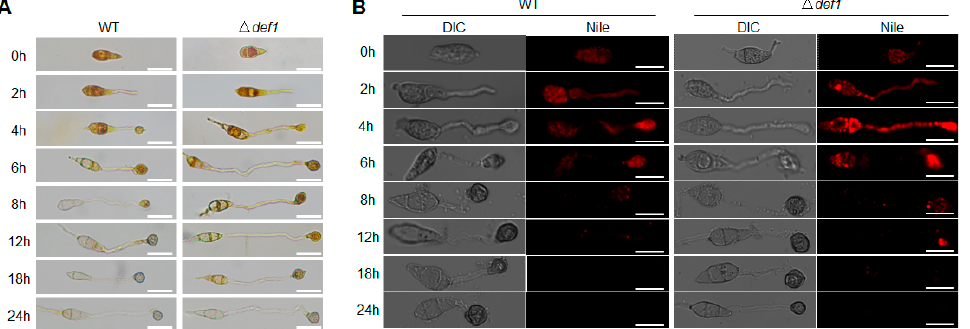
Figure 5. Def1 affects utilization of glycogen and lipid during appressorium development. Stain the wild type (WT) and knock out mutant ∆ def1 with I 2 /KI solution ( A ) and Nile Red ( B ) and observed at different time points during appressorium development. Glycogen was stained and exhibited yellowish-brown color. Lipid was stained and fluoresce red. Bar = 20 μm.